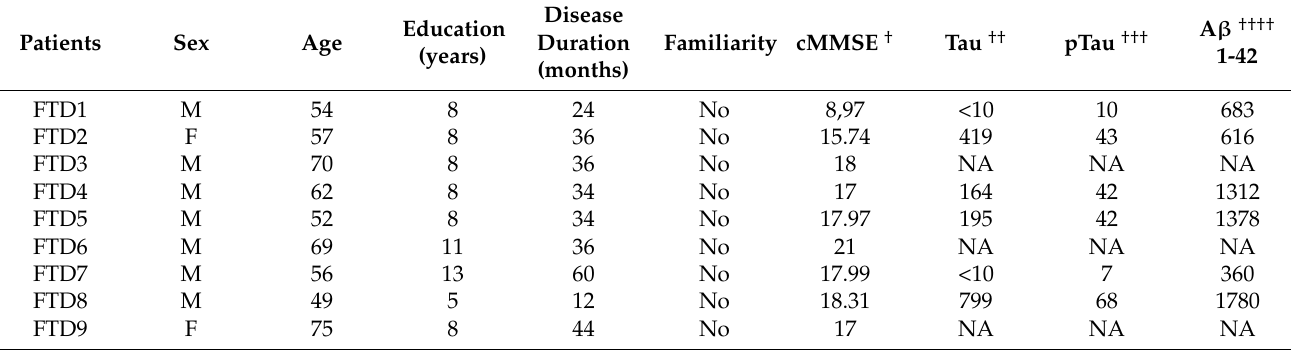
Table 3. Clinical characteristics of FTD